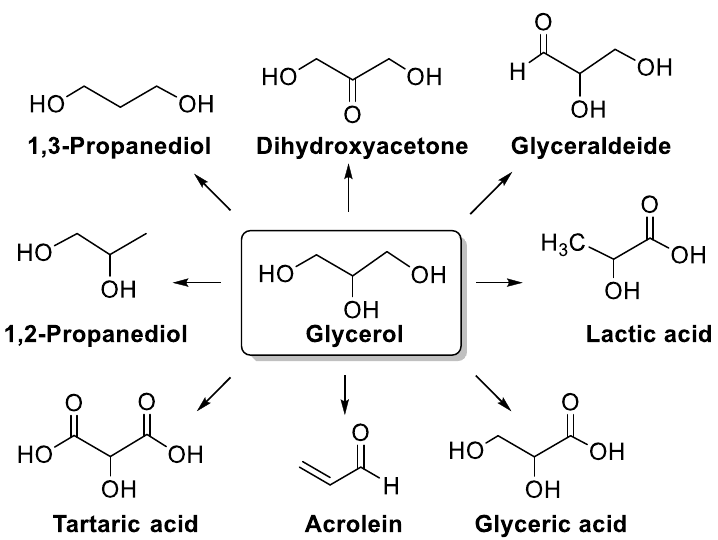
Figure 2. Conversion of glycerol into value-added products.